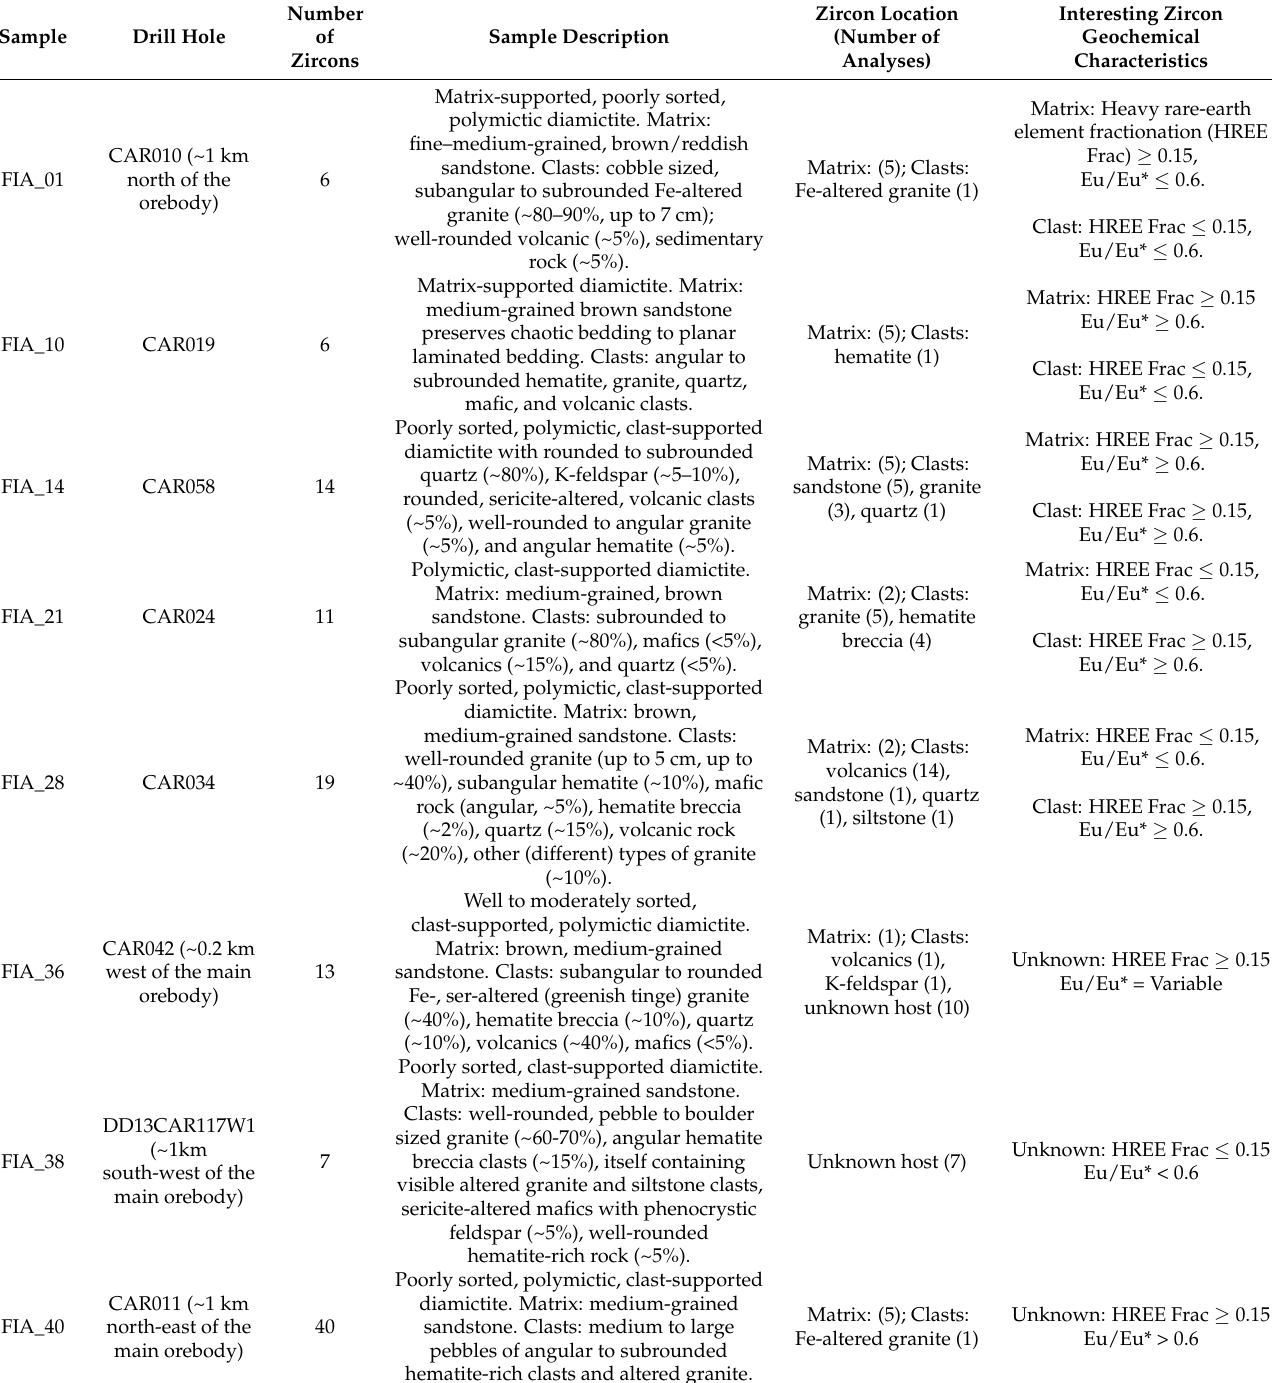
Table 1. Description of basal diamictite samples used for whole-rock geochemical analysis and zircon analysis. Location of samples are shown in Figure